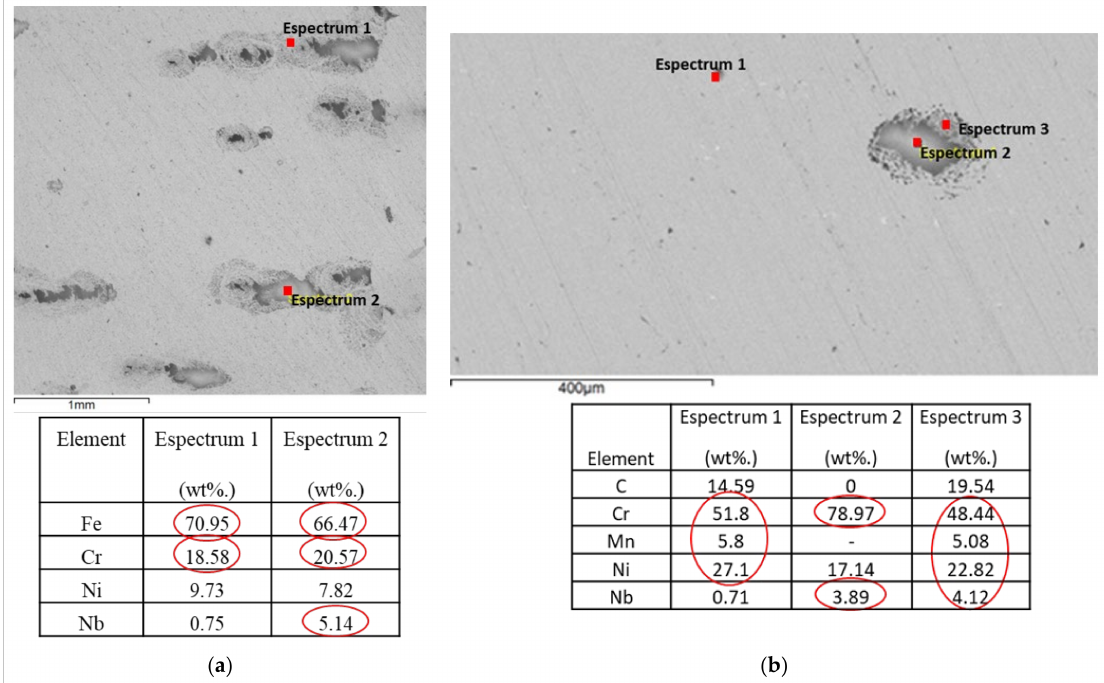
Figure 13. EDS analysis of phases found in substrate pits after EIS measurements: ( a ) region 1; ( b ) region 2. The more important elements were indicated by red